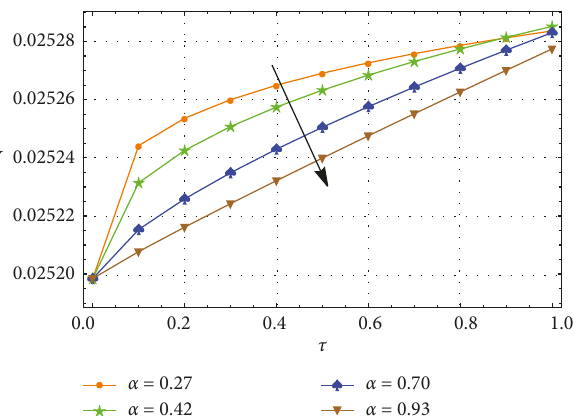
Figure 7: Evaluation of water surface level in Example 2 at different values of α when ρ � 0.1 and x �